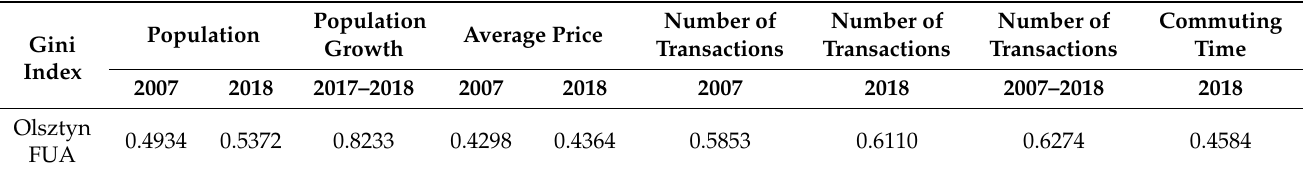
Table 1. Gini index of variables in the suburban zone of